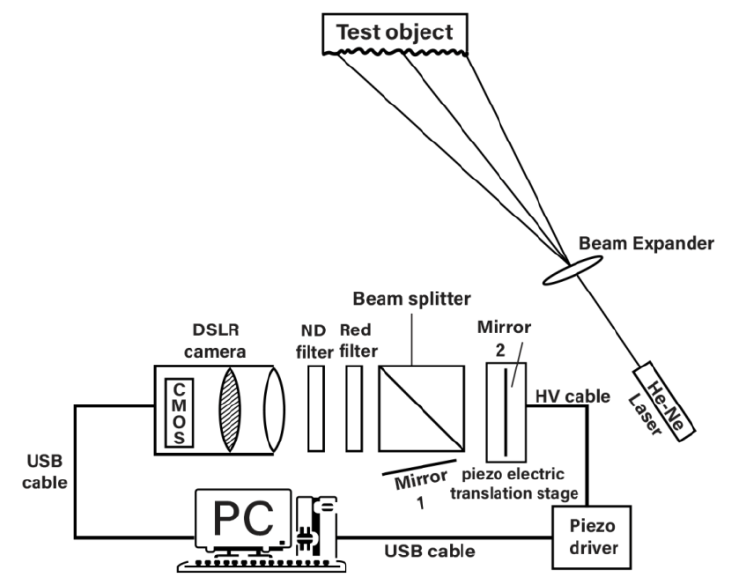
Figure 1. Schematic diagram of the shearographic system.